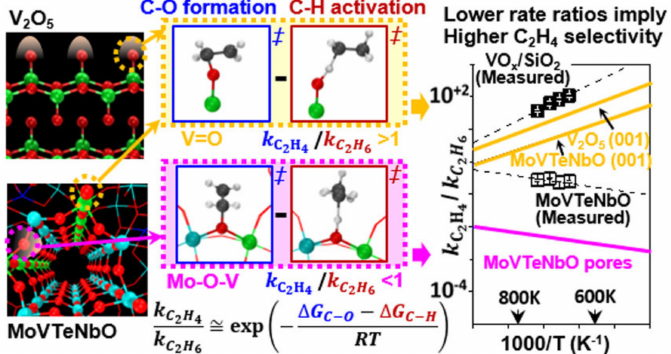
Figure 12. Effects of lattice O atom coordination and pore confinement on selectivity limitations for the ODHE process. Adapted from ref. [93], Copyright (2019), with permission from the American Chemical Society.